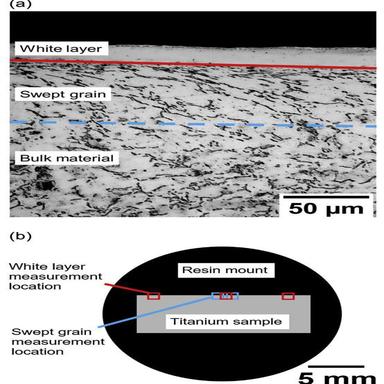
(a) A representative optical micrograph of an etched sample in which measurements were carried out to define the thickness of the white layer and the swept grain depth. The white layer thickness and the swept grain depth are highlighted by the solid and dashed lines respectively. (b) A schematic highlighting the locations of the optical microscopy measurements in a cross-sectional sample.